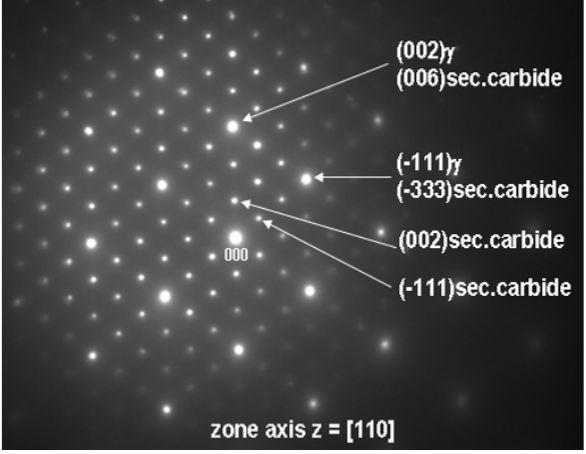
Figure 12. Selected area electron diffraction patterns for lamellar secondary carbide/ γ obtained from regions shown in Figure 11a.